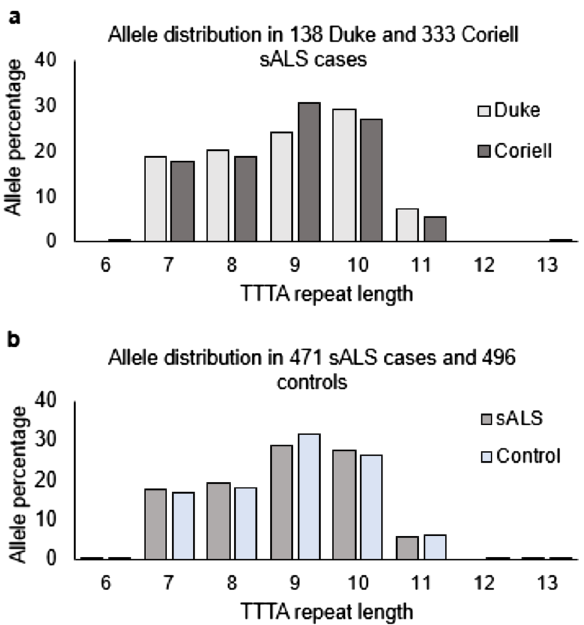
Figure 2. Allele distributions for the NEFH TTTA structural variant in two North American Caucasian cohorts ( a ) Comparison of TTTA allele distribution of 138 Duke sALS cases and 333 Coriell sALS cases. ( b ) TTTA allele distribution in the 471 combined sALS cohort compared to 496 controls. Only one sALS patient in the study had a TTTA repeat length of 15 (not shown in